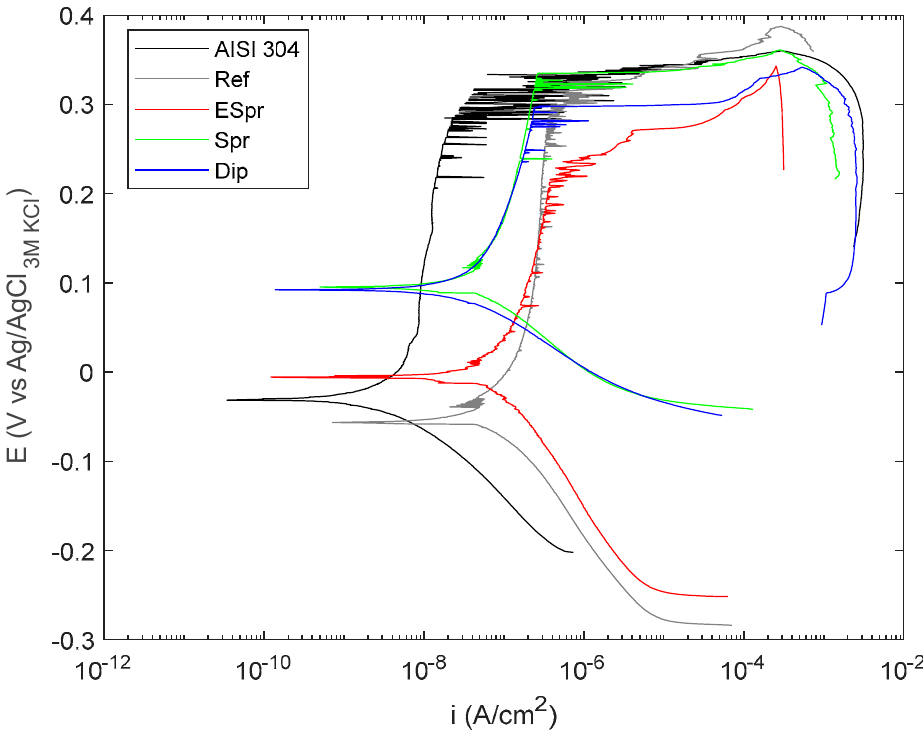
Figure 9. Electrochemical curve results of the potentiodynamic evaluation of functional coatings deposited into AISI304 substrates.